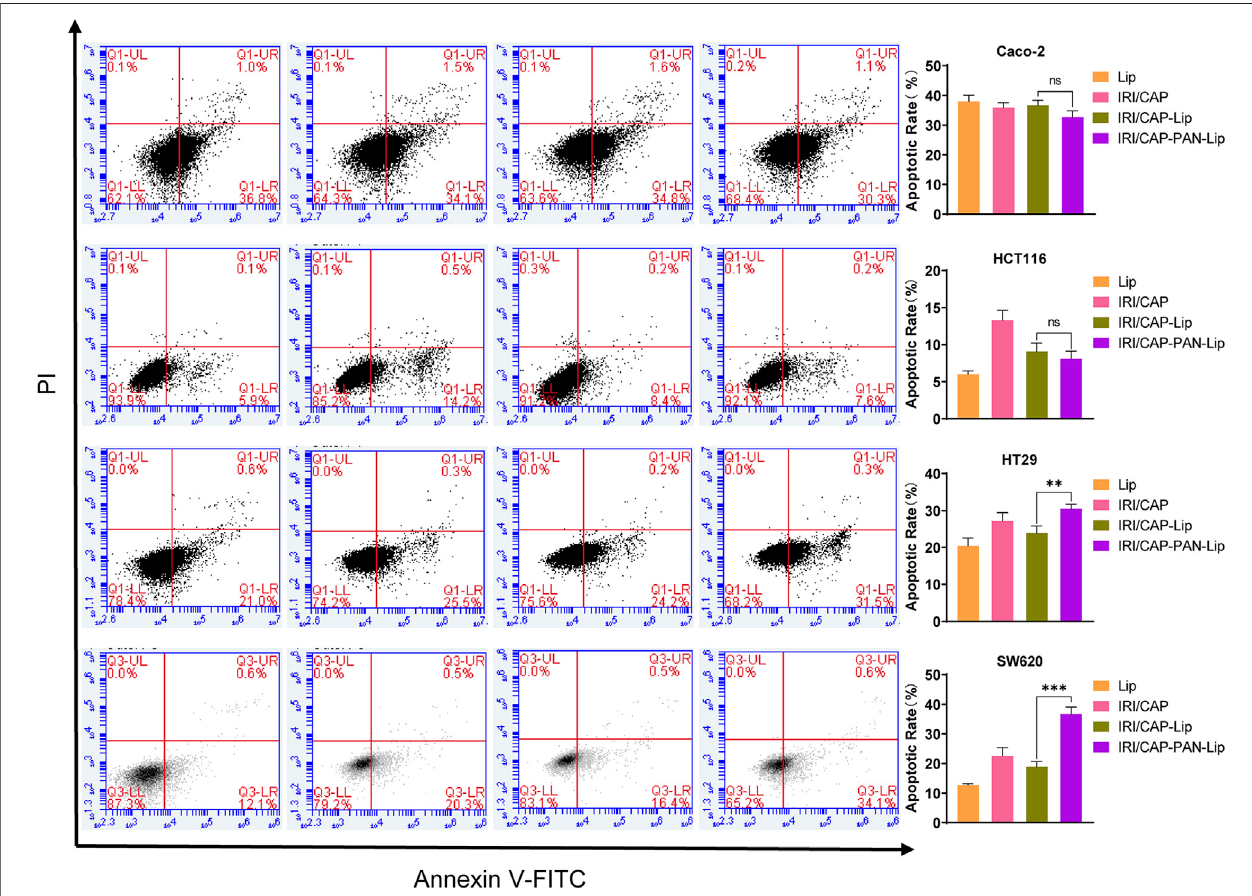
FIGURE7| IRI/CAP-PNA-Lipssigni fi cantlyinducedapoptosiscomparedtoIRI/CAP-LipsinHT29andSW620celllines.TheeffectsofLips,IRI/CAP,IRI/CAP-Lips, andIRI/CAP-PNA-Lipsontheapoptosisofcolorectalcancercelllinesandtheirquantitativehistograms.Thedataarepresentedasthemean±SD( n =3). **p < 0.01. ***p <